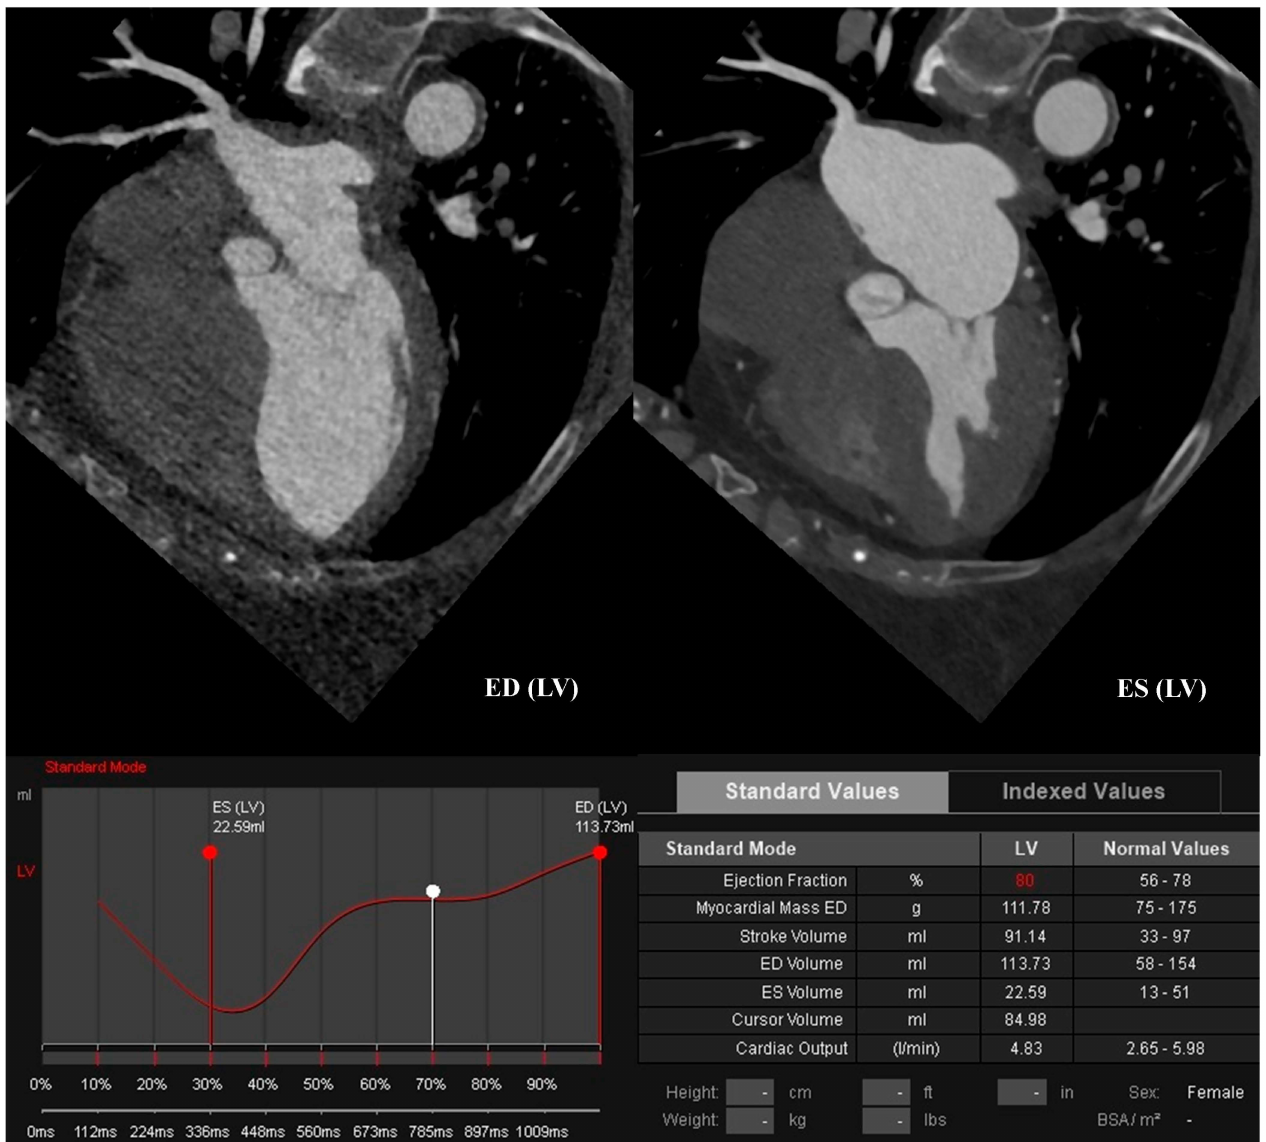
Figure 4. Cardiac computed tomography angiography. Angiographic phase. Left ventricular function assessment—normalleftventricularejectionfraction. ED—end-diastolic, ES—end-systolic, LV—left